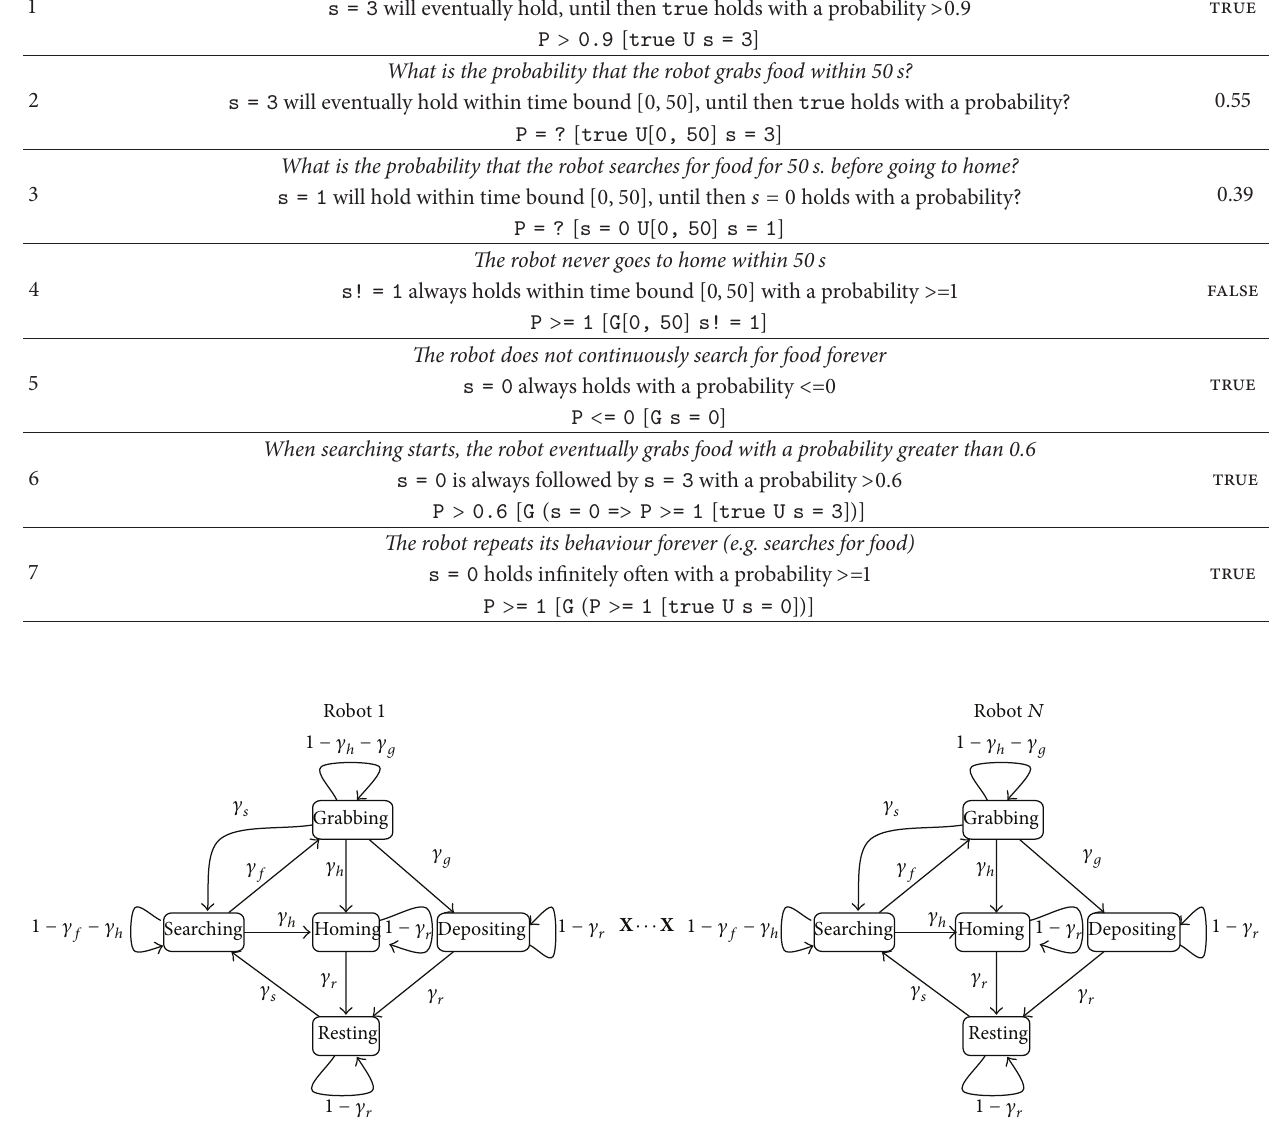
Figure 10: Probabilistic state machine for a foraging swarm.